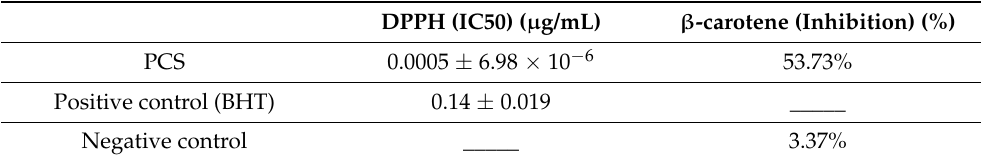
Table 4. Summary of in vitro antioxidant activity